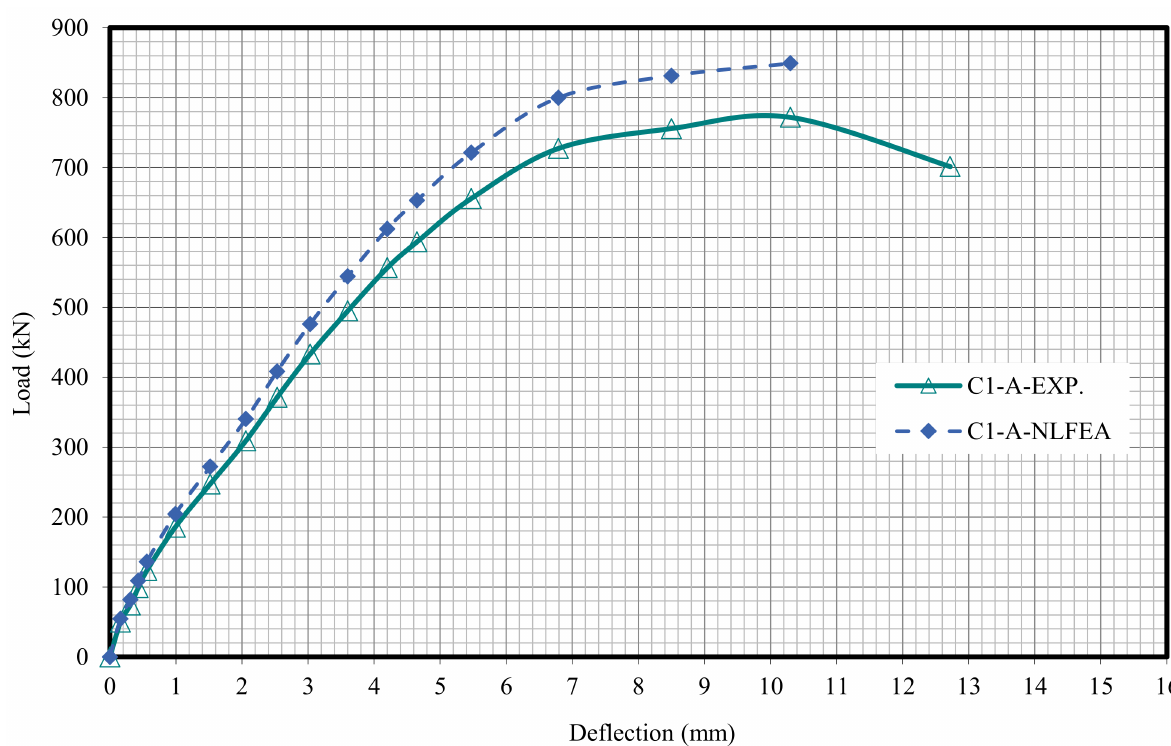
Figure 22. Load deflection of Column